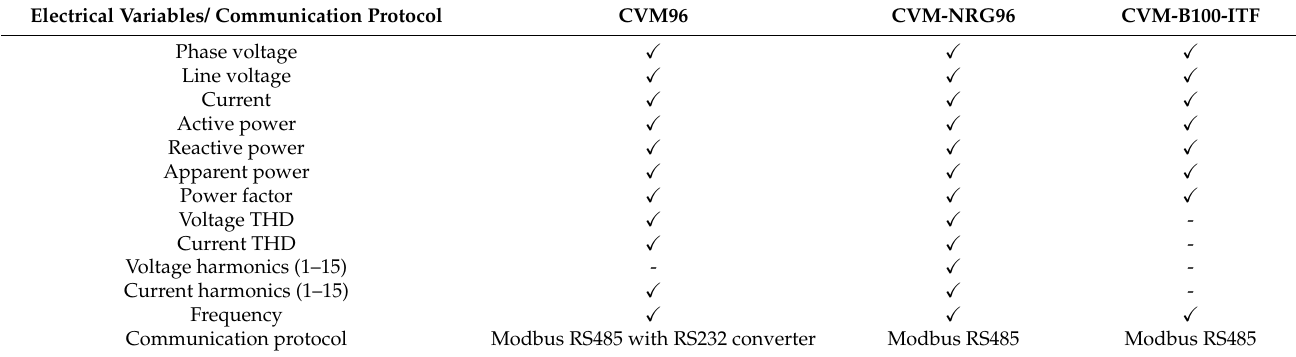
Table 6. Main electrical variables and communication protocol of power analyzers.